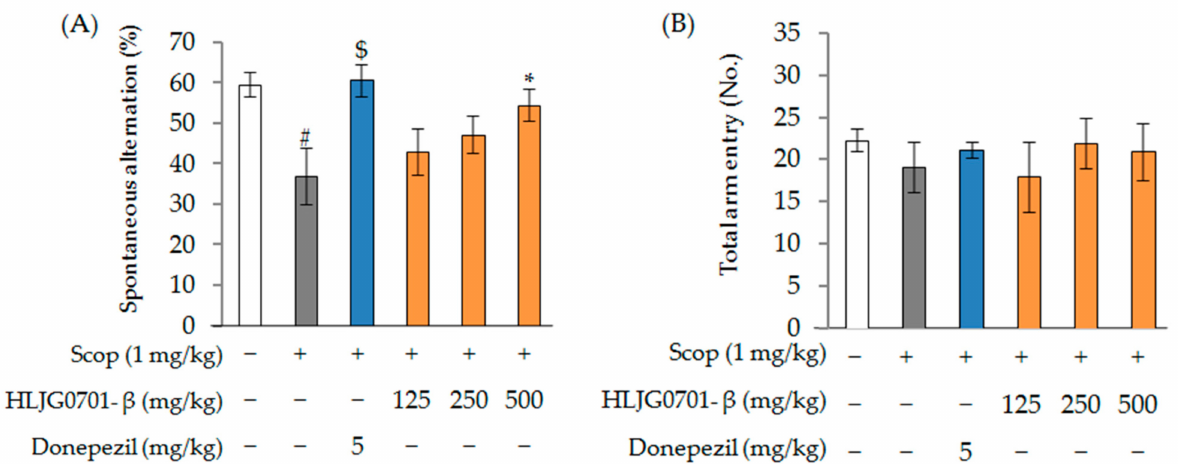
Figure 6. The Y-maze task in scopolamine-induced male mice. ( A ) Spontaneous alternation; ( B ) Total arm entry. Data are presented as mean ± standard deviation, Error bar: standard deviation. #, significant difference compared with control by Student’s t -test, p < 0.05; $, significant difference compared with scopolamine group by Student’s t -test, p < 0.01; *, significant difference compared with scopolamine group by one-way ANOVA, p <